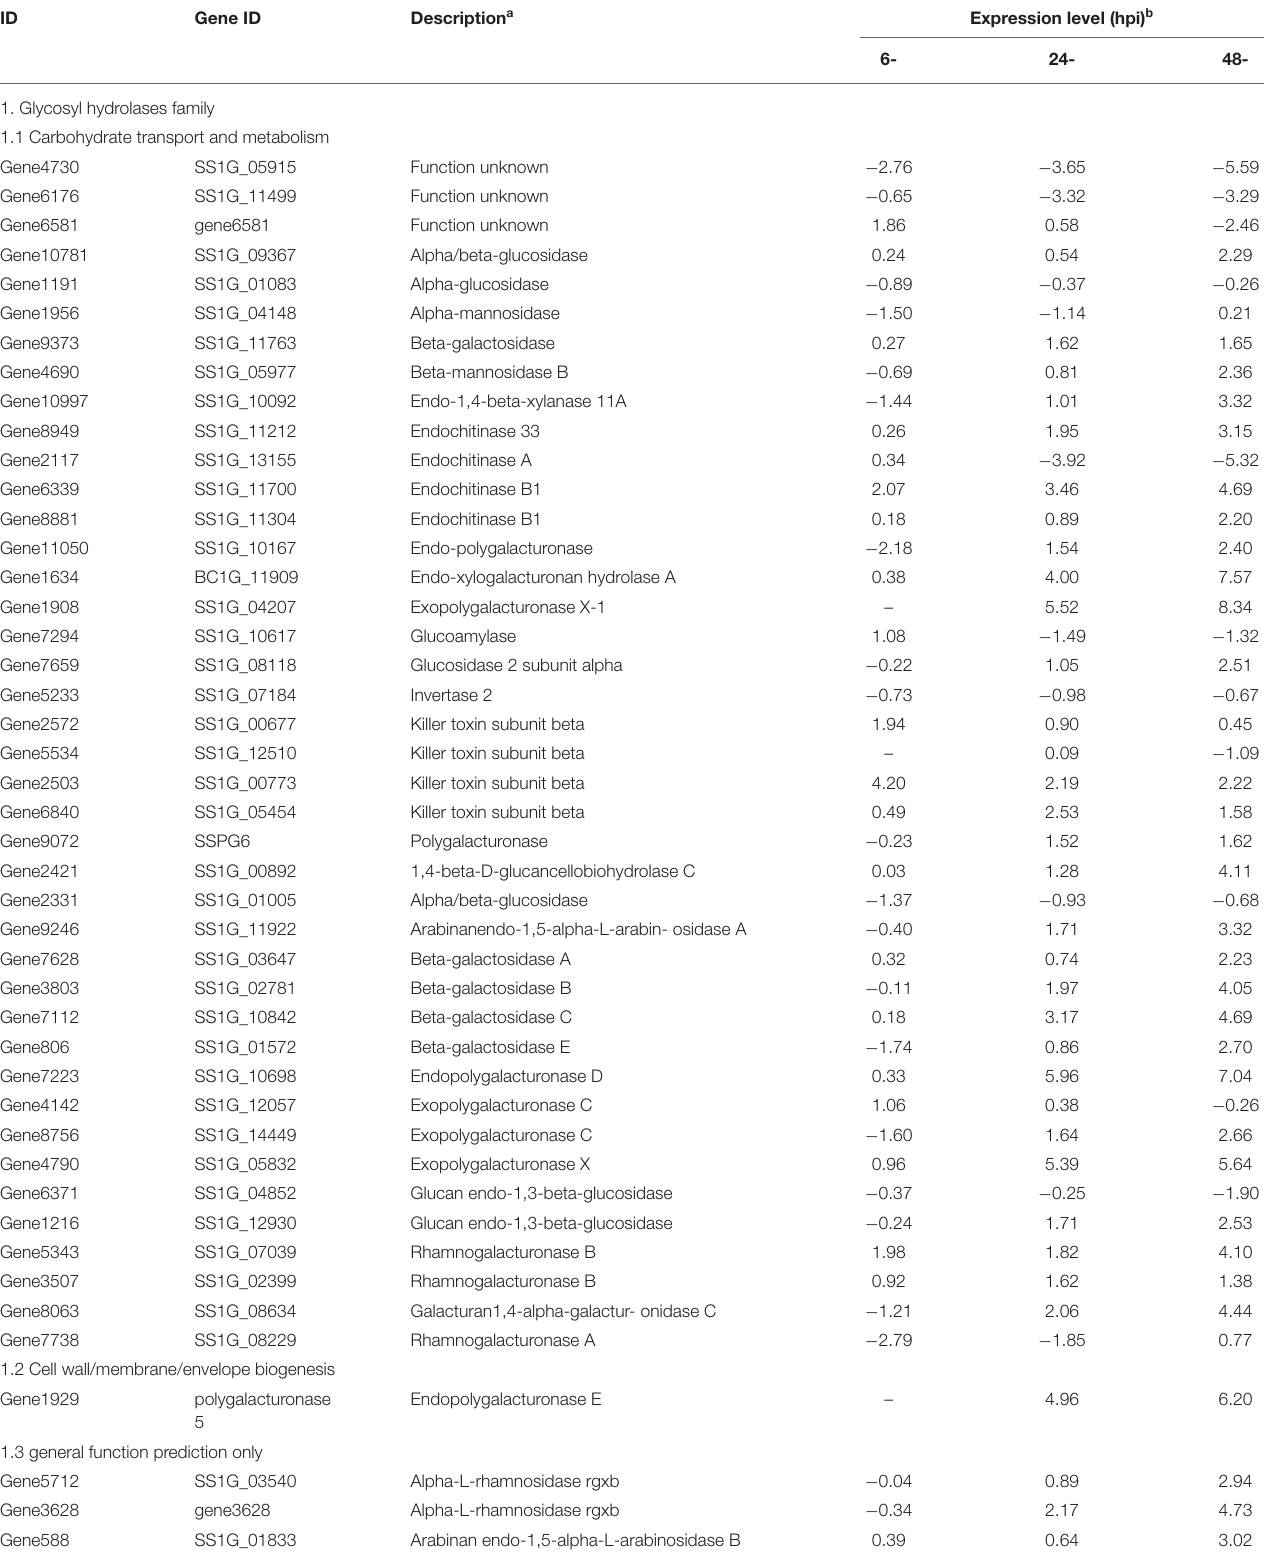
TABLE 2 | Description and expression of genes in S. sclerotiorum involved in